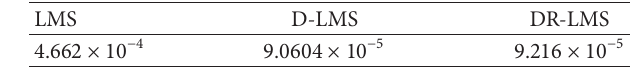
Table 2: Mean square error (1024